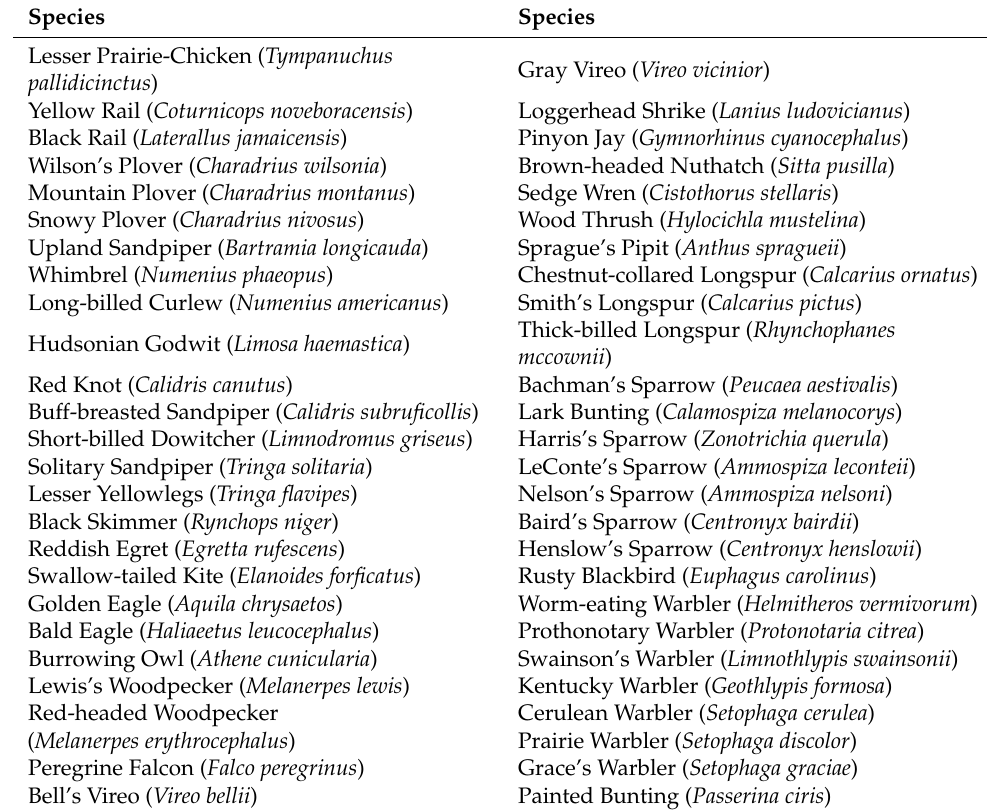
Table 1. Bird species of conservation concern in US Fish and Wildlife Region 2, which includes Arizona, Oklahoma, New Mexico, and Texas. Only species that have been officially recorded in Oklahoma based on Oklahoma Bird Records Committee [33] are shown, and taxonomy follows the American Ornithological Society